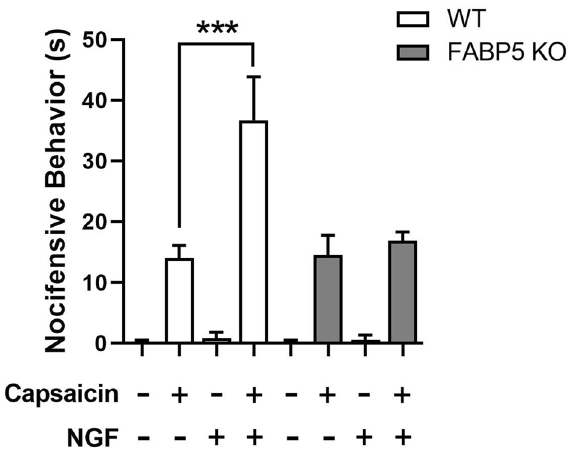
Figure 7. Capsaicin-induced nocifensive behavior in WT and FABP5 cKO mice. Mice received an intraplantar injection of vehicle or 200 ng NGF followed by vehicle or 1 µg capsaicin. The duration of nocifensive behavior defined as paw licking or biting was subsequently scored for 5 min. * p < 0.05 calculated using unpaired t test (n =